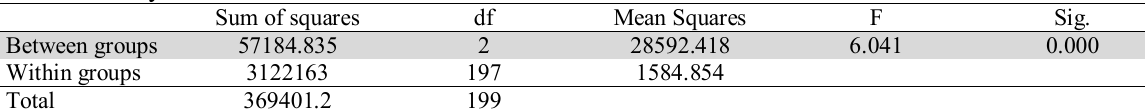
The summary of ANOVA test Sum of squares df Mean Squares F Sig. Between groups Within groups